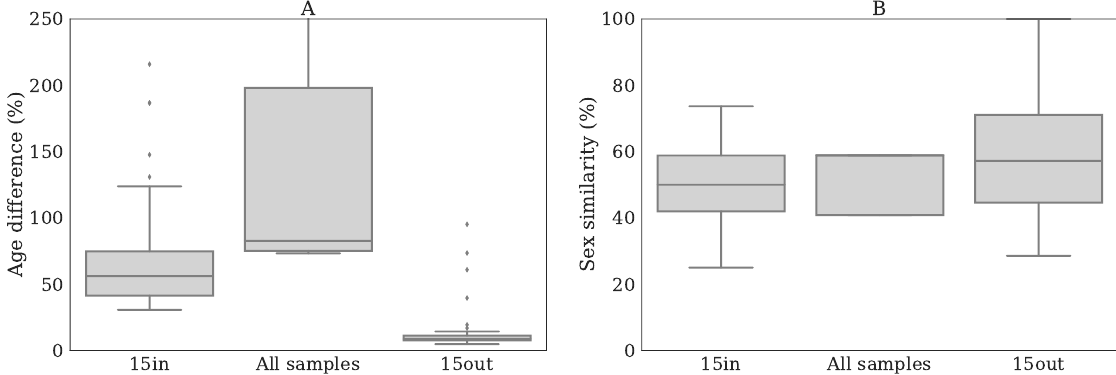
Figure A6. ( A ) Difference in age between patient and the reference samples for every Z-score method. Mean age difference was determined by calculating the difference in age of the patient with the references divided by the age of the patient (times 100%) whereafter the mean was taken. ( B ) Similarity in sex between patient and controls for every